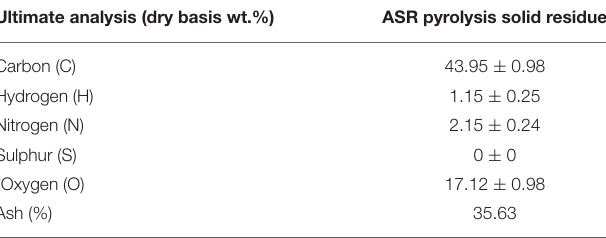
observed from Table 3 that tridymite is formed from 900 ◦ C. The predicted temperature is close to the temperature in the reactor.